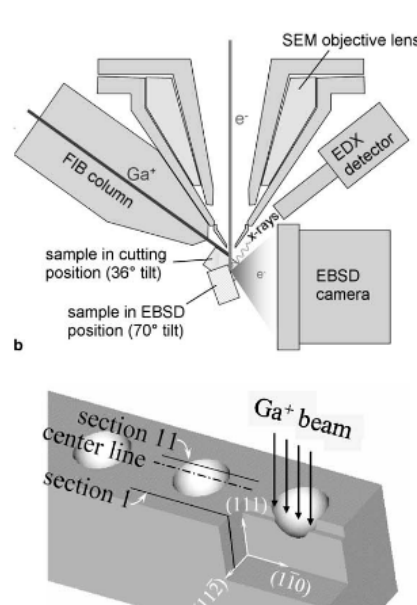
Figure 20. Rotation angles and rotation directions in the (11 2(cid:3364) ) plane [45].